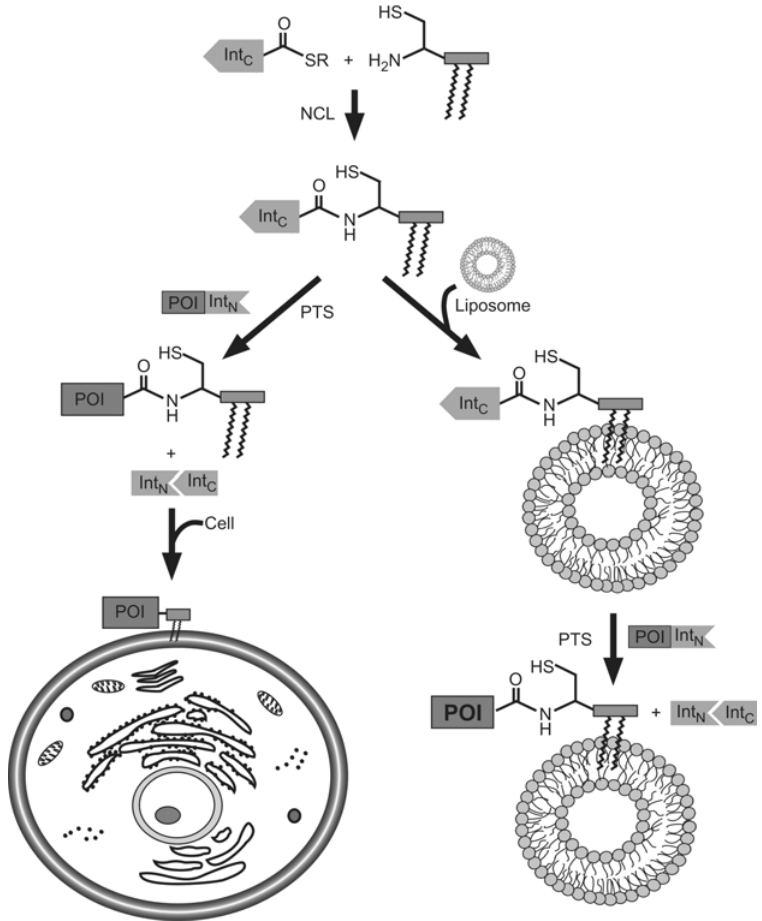
Figure 6 Site-specific lipidation via protein trans -splicing (PTS). Using NCL, the C-terminal fragment of the Ssp DnaE split intein was fused to a short, doubly palmitoylated C-extein sequence (yielding peptide I CPalm ). The latter lipidated extein sequence could then be incorporated at the C-terminus of a protein of interest (POI) via PTS, and the lipidated POI attached to the outer membrane of a mammalian cell (left path). In another experimental set-up, the native